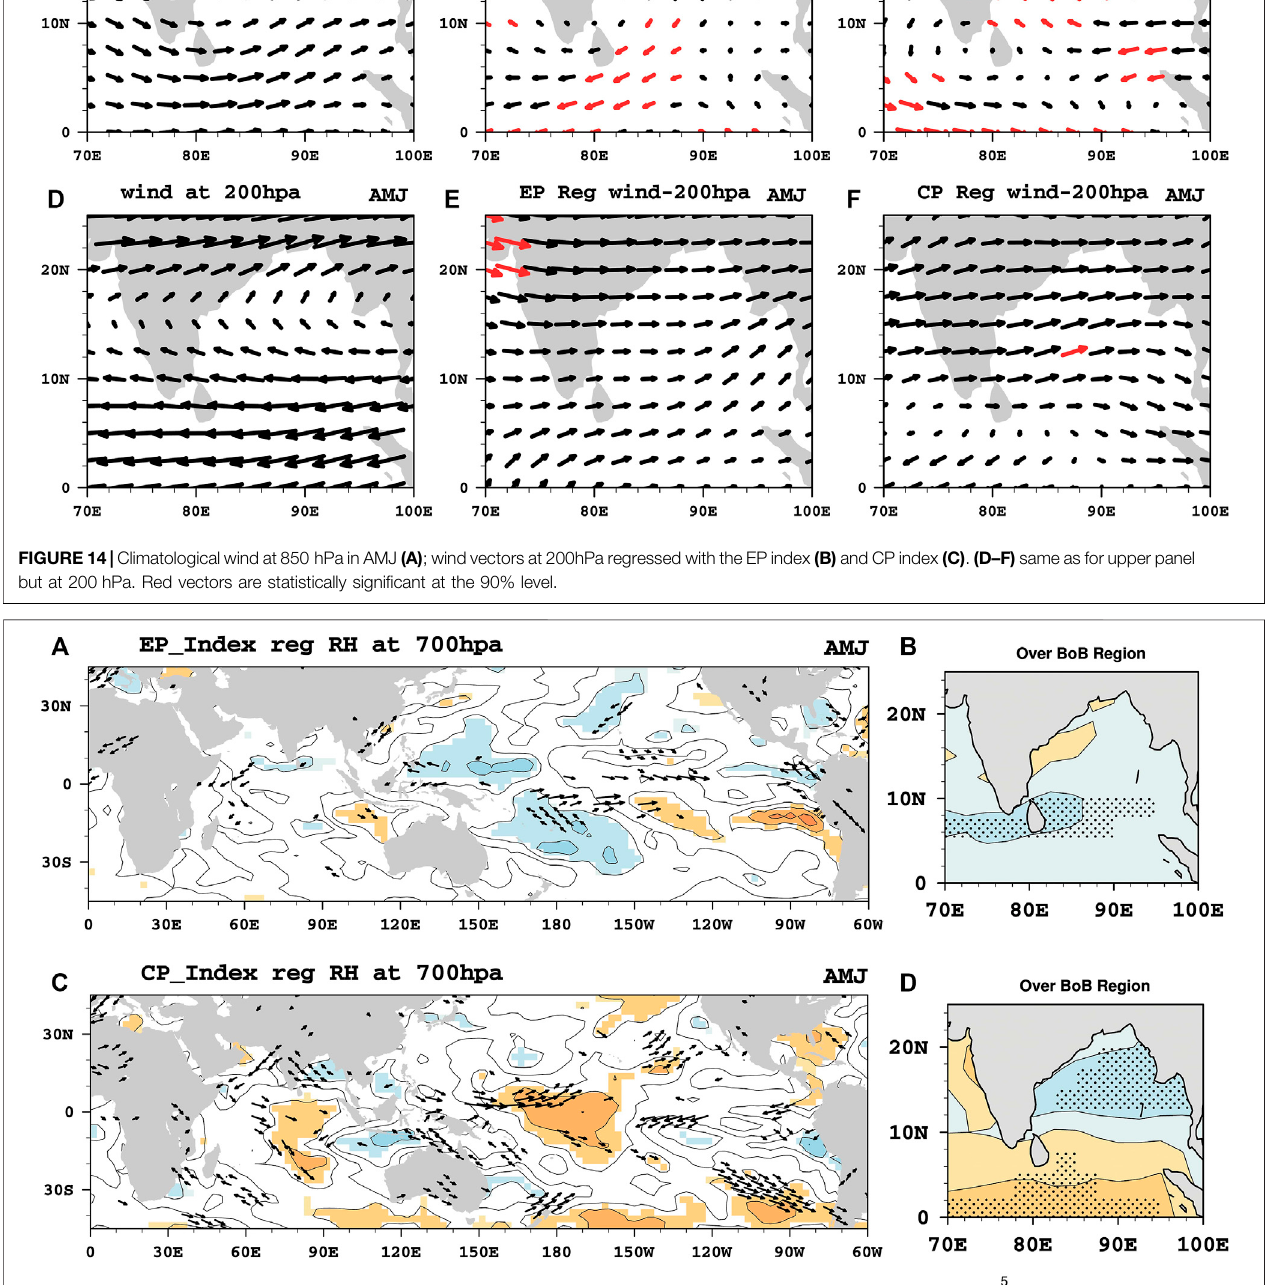
Frontiers in Earth Science |